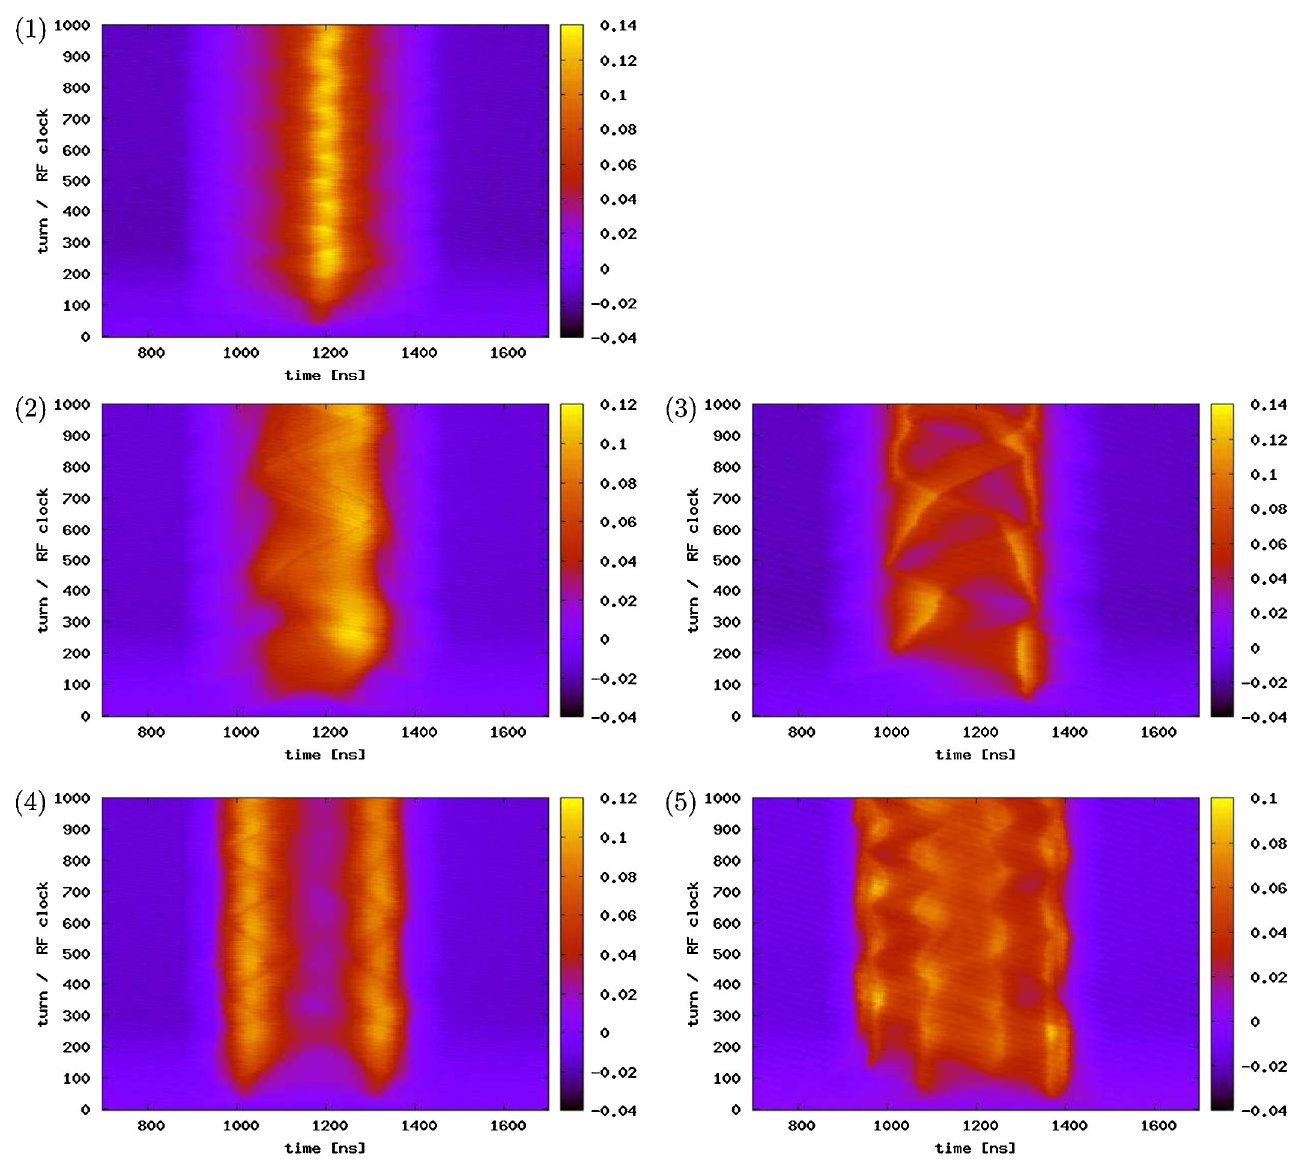
FIG. 4. (Color) Mountain plots of the longitudinal beam signal. (upper left) (1) Fundamental rf only; (middle left) (2) with 50% second harmonic to the fundamental; (middle right) (3) with 50% second harmonic and momentum offset of (cid:1) 0 : 2% ; (lower left) (4) with 80% second harmonic; (lower right) (5) with 80% second harmonic and momentum offset of (cid:1) 0 : 2%